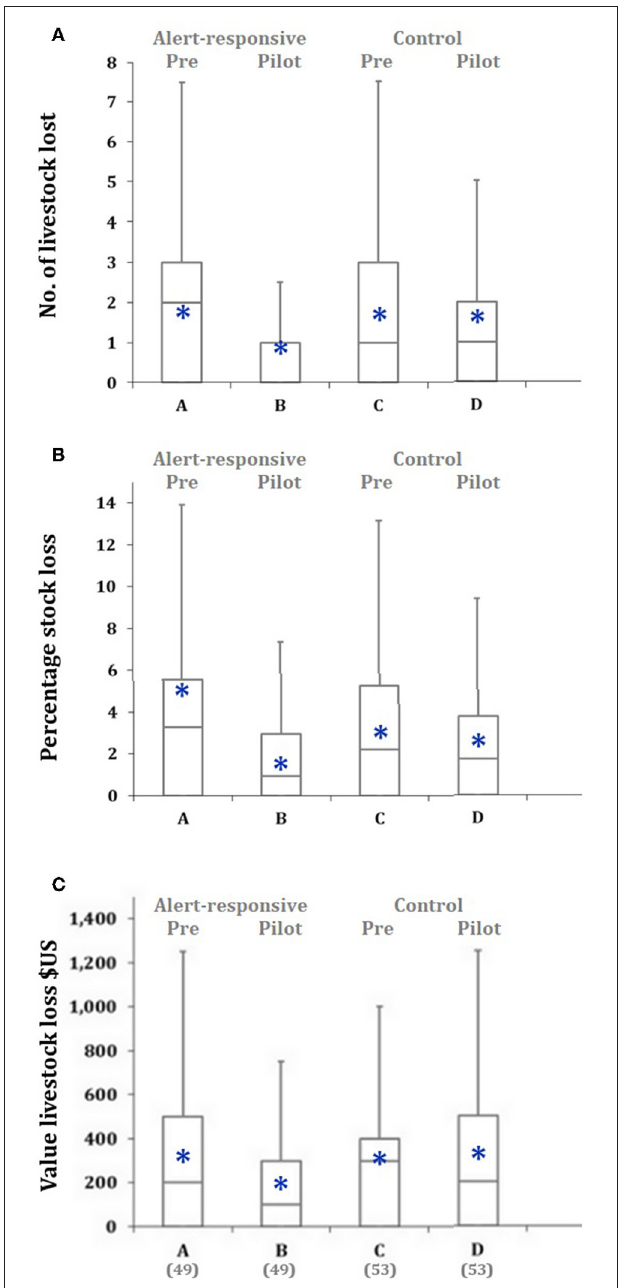
FIGURE 6 | Comparison of annual lion-related livestock losses (A) , percentage stock loss (B) , and associated compensation value ($US) (C) for responsive alert recipients before (A) and during alerts (B) and a control group of non-responsive recipients before alerts (C) and during alerts (D). Blue asterisks show mean values. Sample sizes are shown in parentheses. Livestock losses were recorded from May 2015 until April 2016 for the pre-alert phase and from November 2016 until October 2017 for the alert phase.